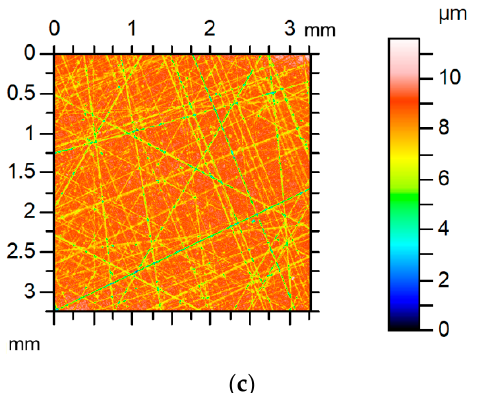
Figure 9. Contour plots of surface C ( a ), of surface D ( b ), and of equivalent sum surface ( c ).